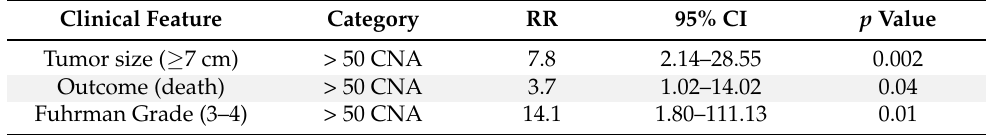
Table 5. Multivariate analysis of CNA